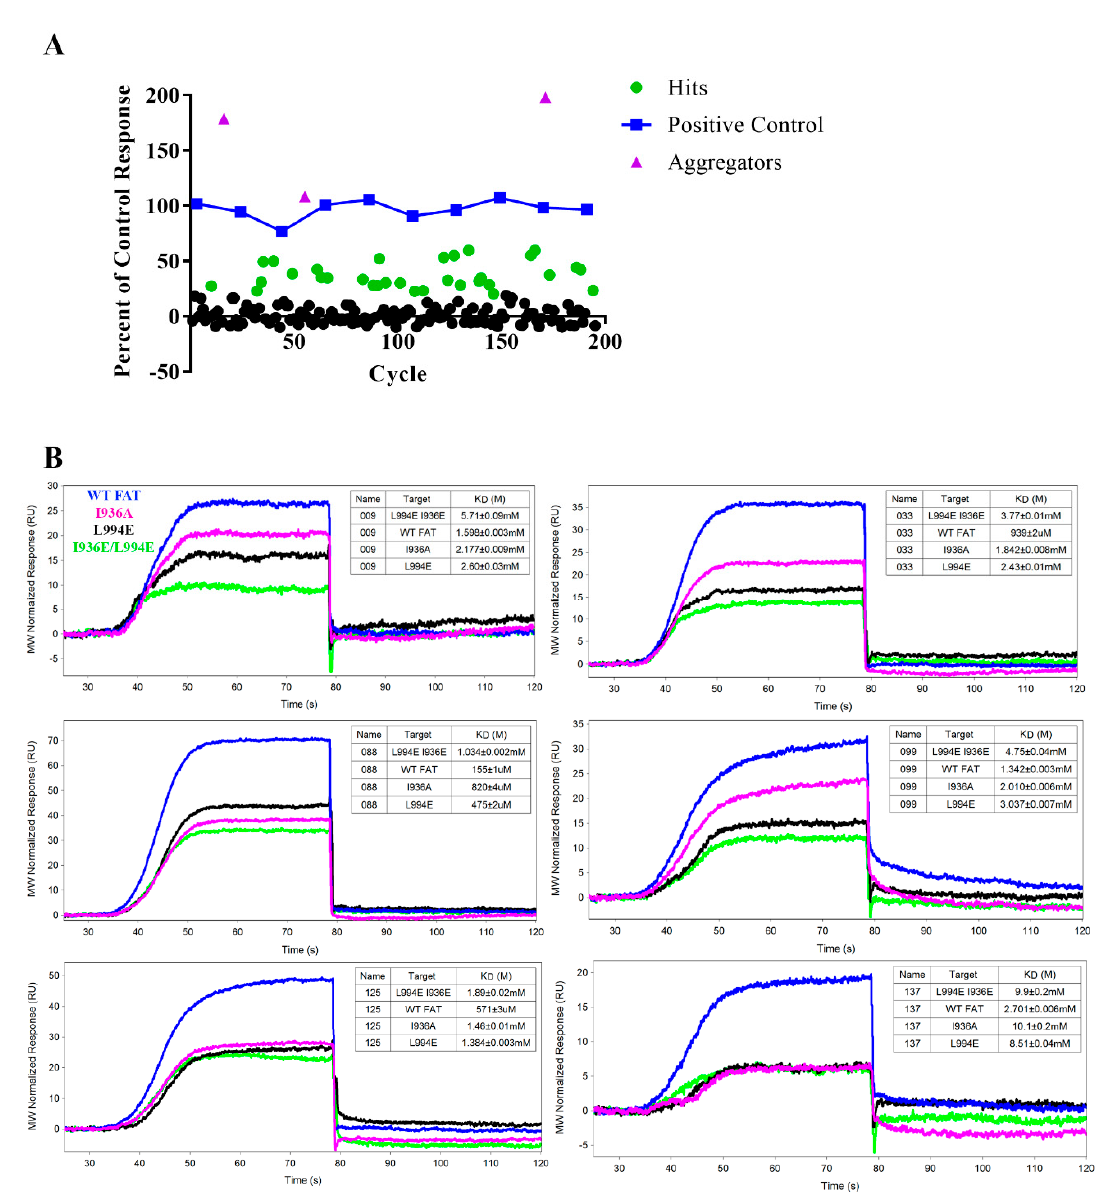
Figure 5. Pilot SPR fragment screen ( A. ) Hit plot displaying results of the primary SPR fragment screen with WT AviTag FAT compared to a control compound found through a fluorescence polarization assay. Hits were characterized as having 20% of the control response. Three hits were above the 100% control response, but analysis of the binding curves showed curves that they didn’t reach equilibrium indicating aggregation and were ruled out as hits. The primary screen produced a total of 32 initial hits. ( B ) Six representative SPR sensorgrams of fragment hits with binding to WT FAT (blue), single mutants I936A (pink), L994E (black), and double mutant I936E / L994E (green). Each binding curve displays their respective K D . Careful visual inspection of the binding curves allowed for a final curated hit count of 19 fragments.